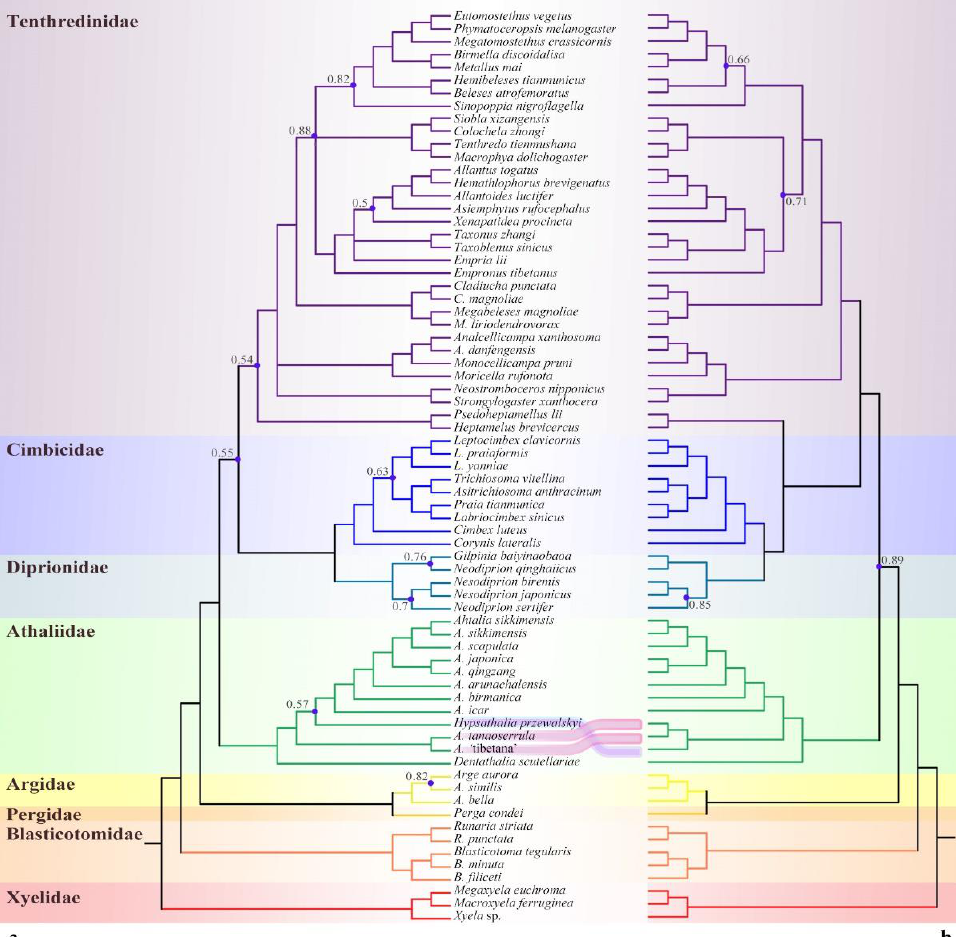
Figure 3. Topological comparison of PhyloBayes trees based on the concatenated nucleotide sequences of ( a ) the 13 PCGs and ( b ) the 13 PCGs and 2 rRNAs, showing species group sampling and points of agreement and conflict. Posterior probability support values less than 0.90 are displayed on the trees with blue dots.